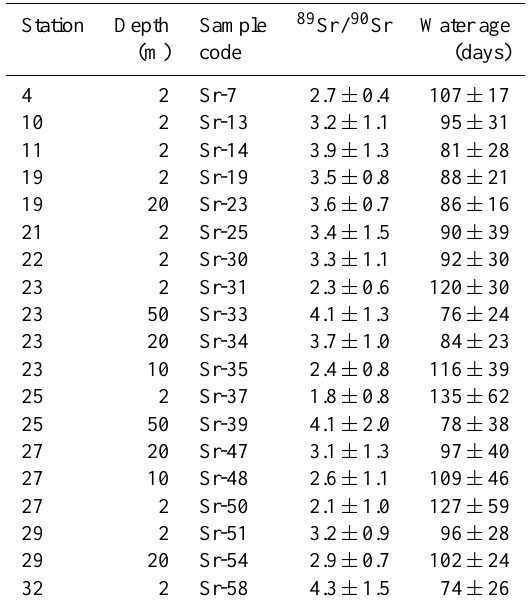
Table 2. 89 Sr/ 90 Sr ratio in seawater samples and resulting ages obtained from Eq.